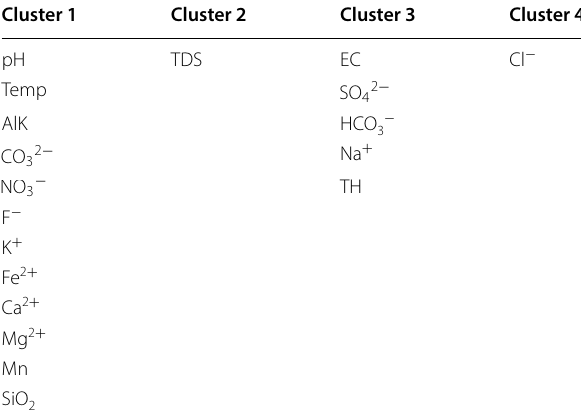
Table 4 Cluster grouping of the water quality parameters